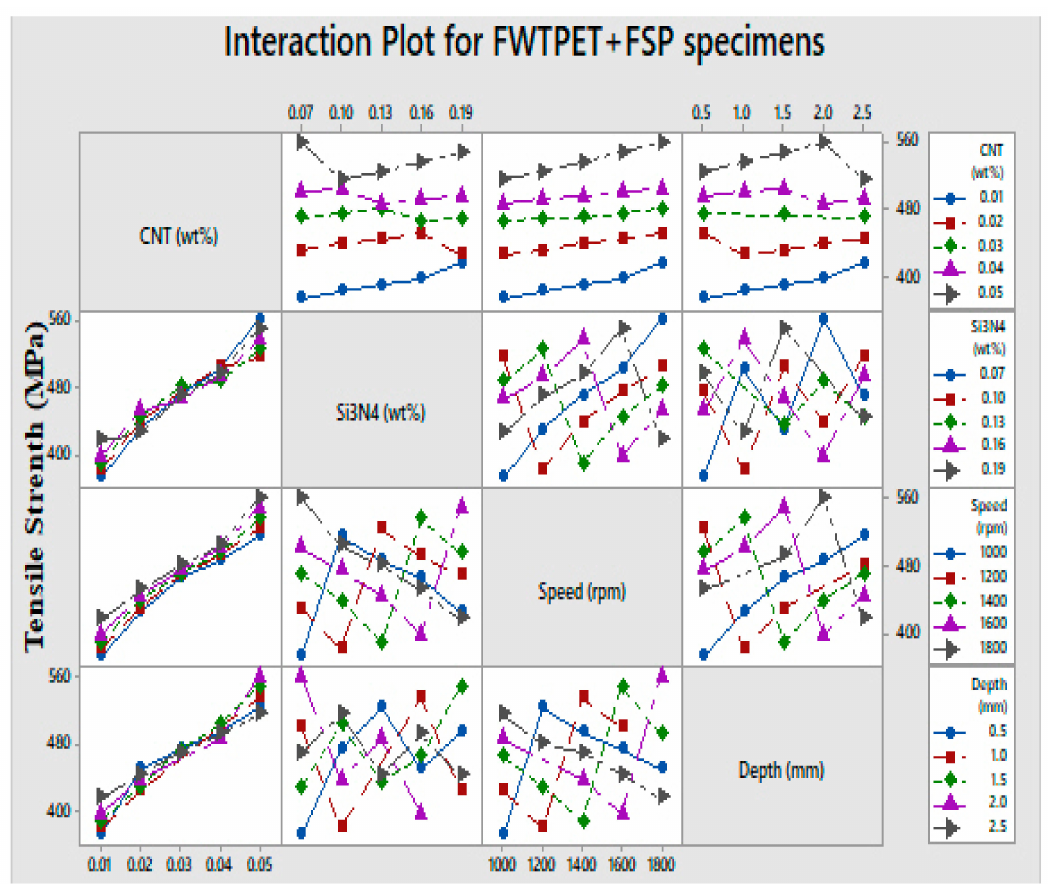
Figure 7. Interaction plots for FWTPET + FSP